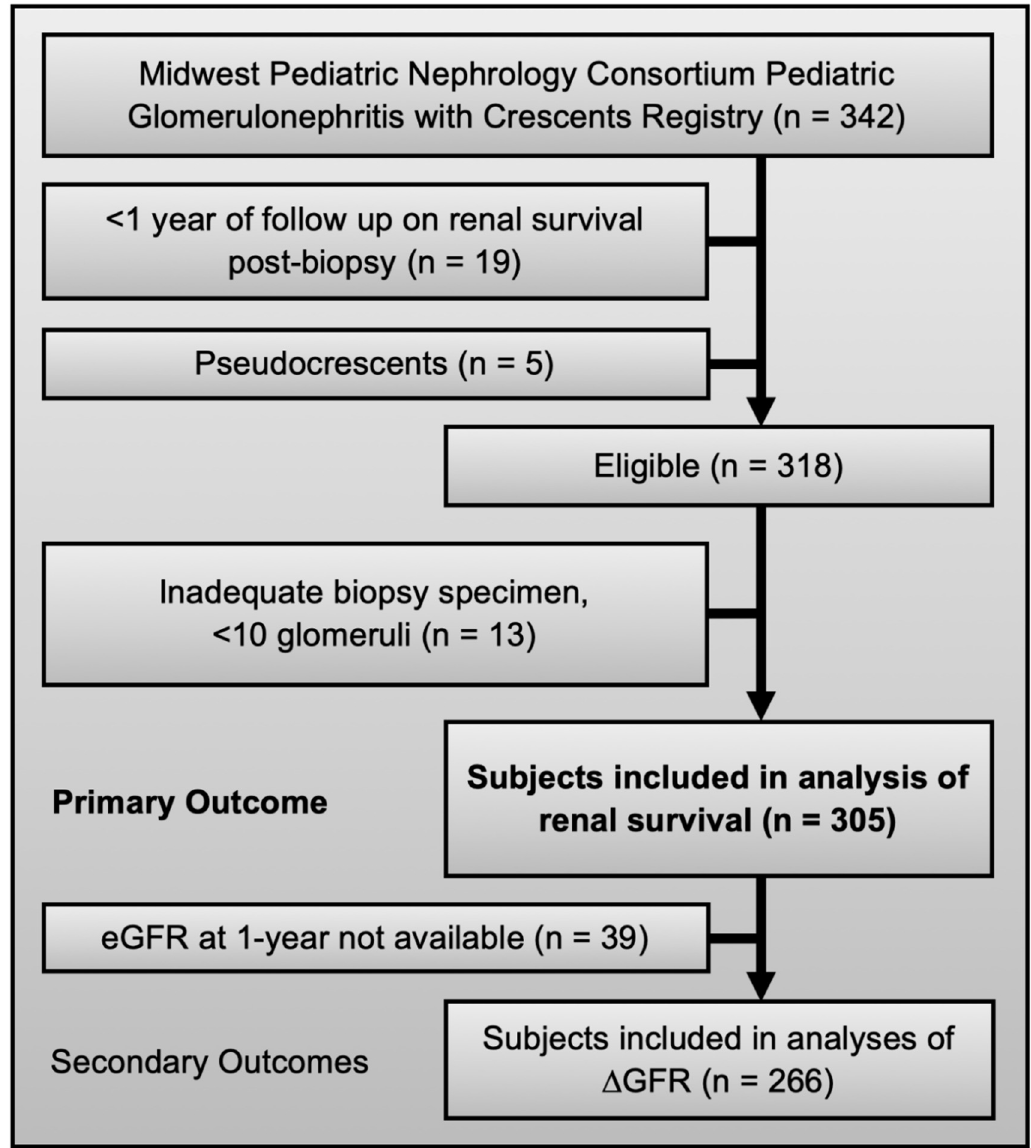
Figure 1. Eligibility and inclusion criteria for the registry and this study.